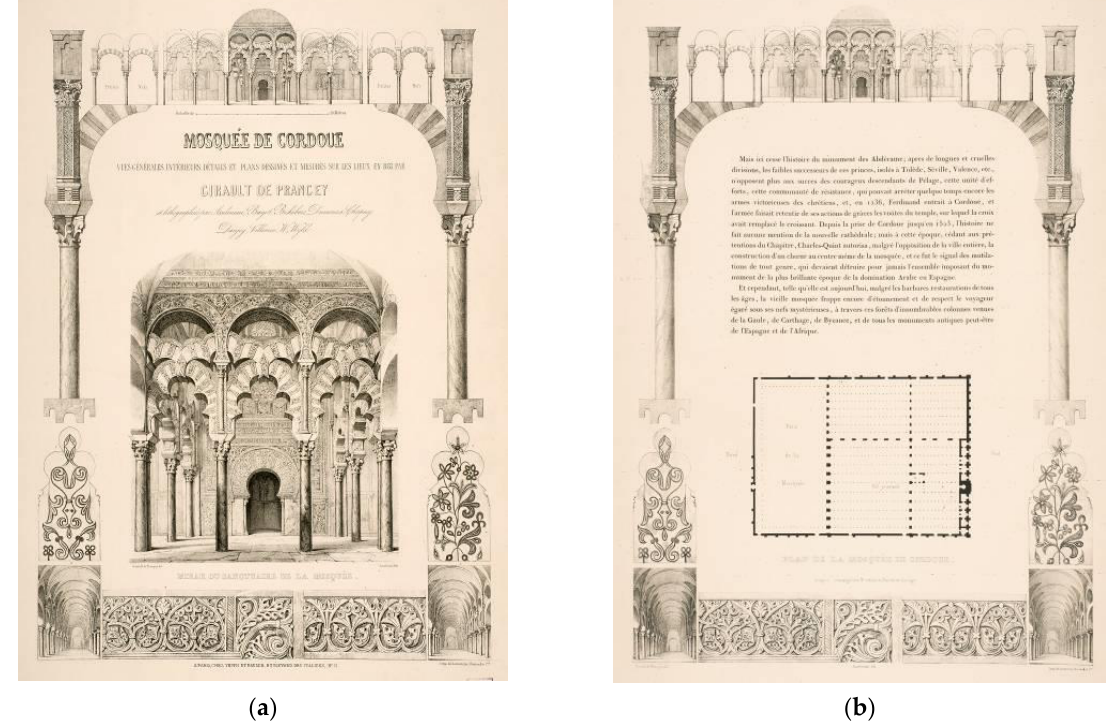
Figure 5. Girault de Prangey: ( a ) Publication cover including mihrab view (Asselineau, lit.) ( b ) Building plant hypothesis in the Islamic period. Source: Monuments arabes et moresques de Cordoue, Seville et Grenada, 1839.